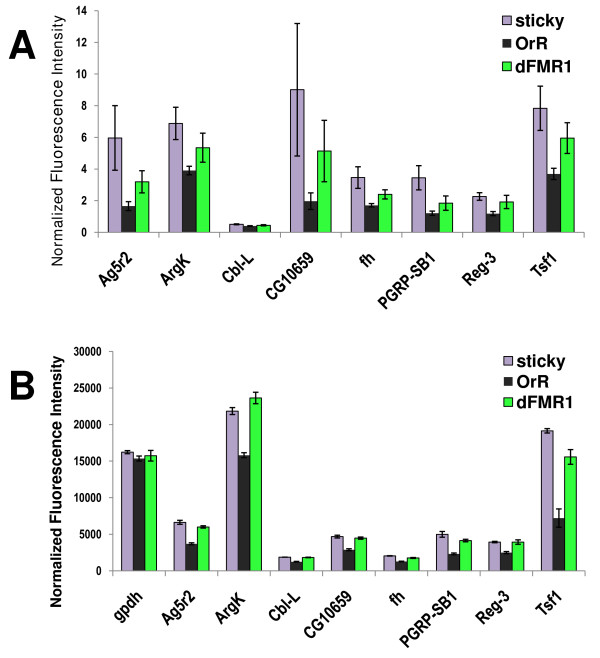
RT-PCR quantitation of mRNA levels for candidate genes. (A) Mean gene expression levels with standard errors as measured by RT-PCR. For each gene, band intensity was normalized to gpdh expression from the same cDNA template. (B) Mean gene expression levels with standard errors as measure by microarray.